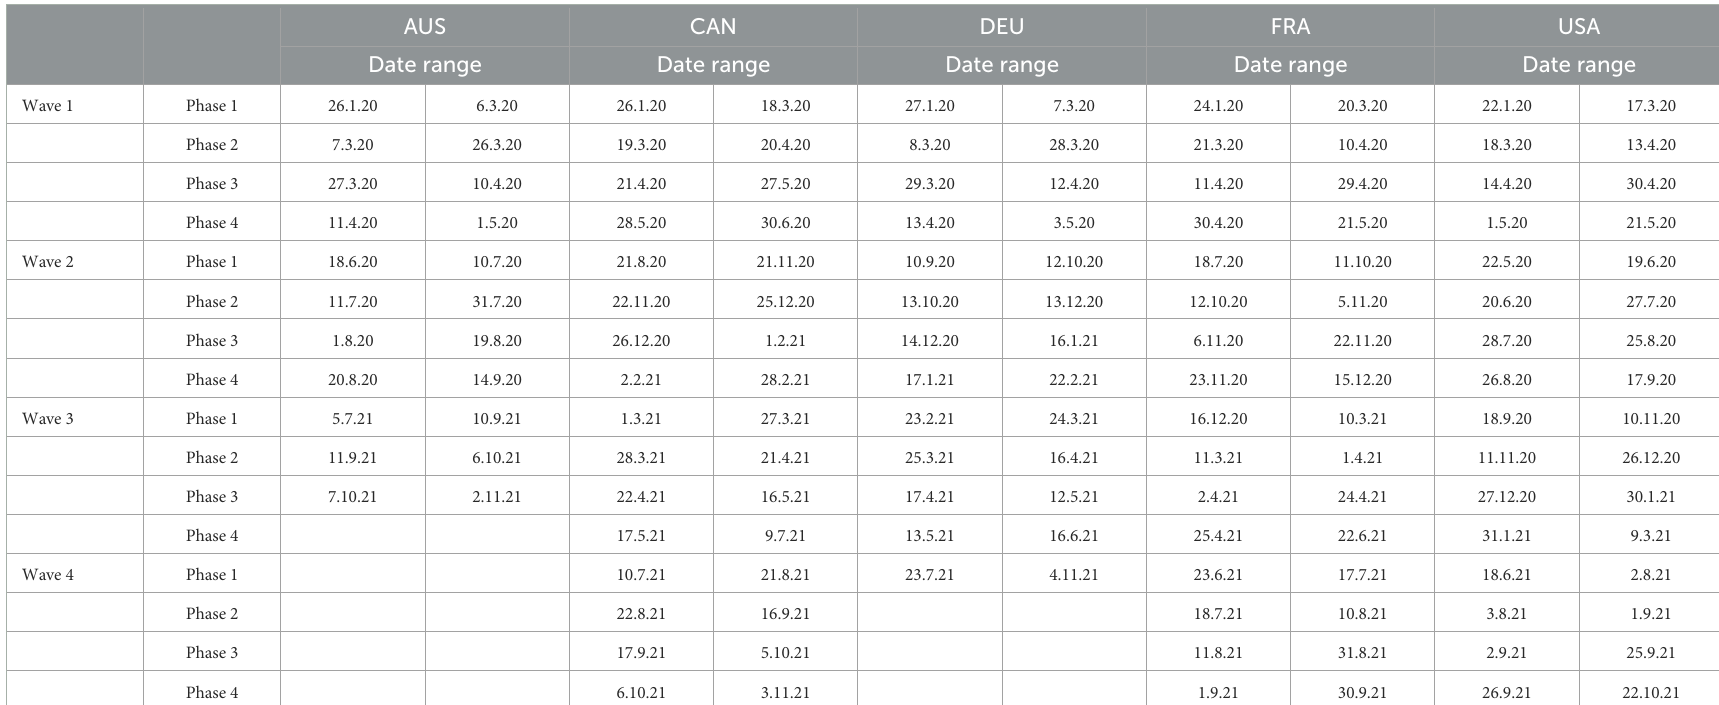
TABLE 2 The estimation of wave and phases by using cumulative Fourier transform. AUS CAN DEU FRA USA Date range Date range Date range Date range Date